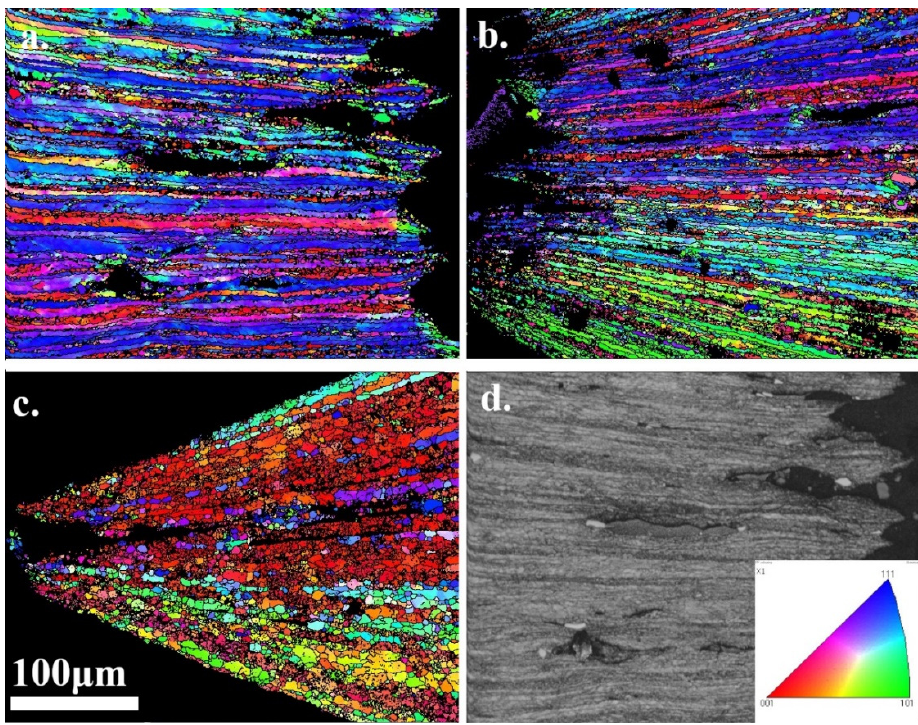
Figure 5. EBSD maps of failure region of specimens post-formed at 1 × 10 − 1 s − 1 at ( a ) 350 °C, ( b ) 400 °C and ( c ) 500 °C and ( d ) band contrast image detailing tearing around intermetallics.